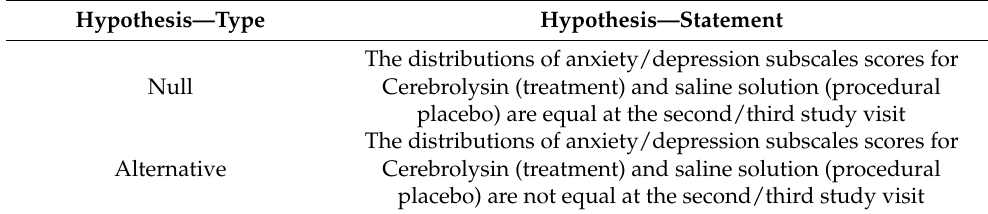
Table 3. Study hypotheses for the Mann–Whitney U test.